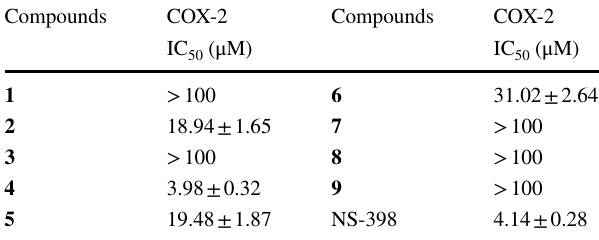
Table 3 Inhibitory effects of Compounds 1 - 9 against COX-2 in Vitro Compounds COX-2